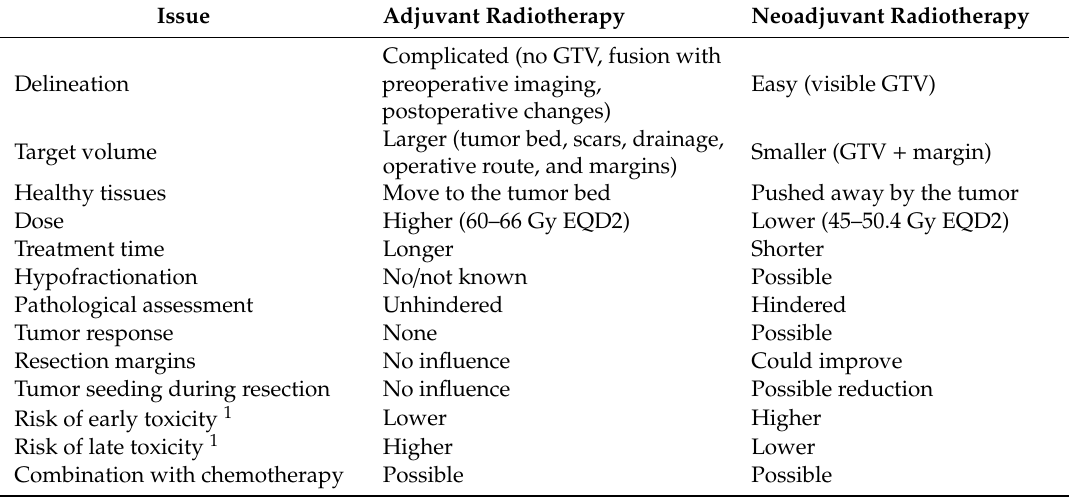
Table 1. Comparison of neoadjuvant and adjuvant radiotherapy in soft tissue